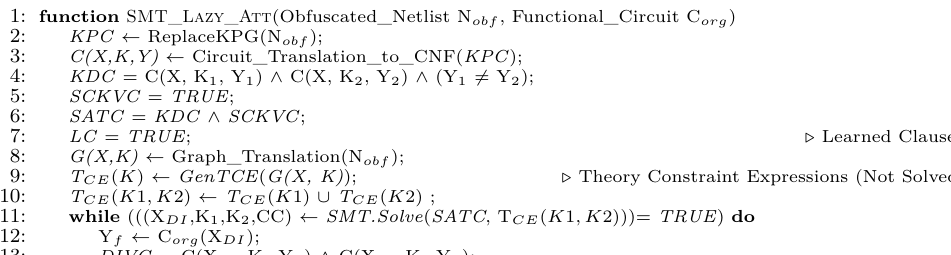
Algorithm 3 Overall SMT Attack ( Lazy